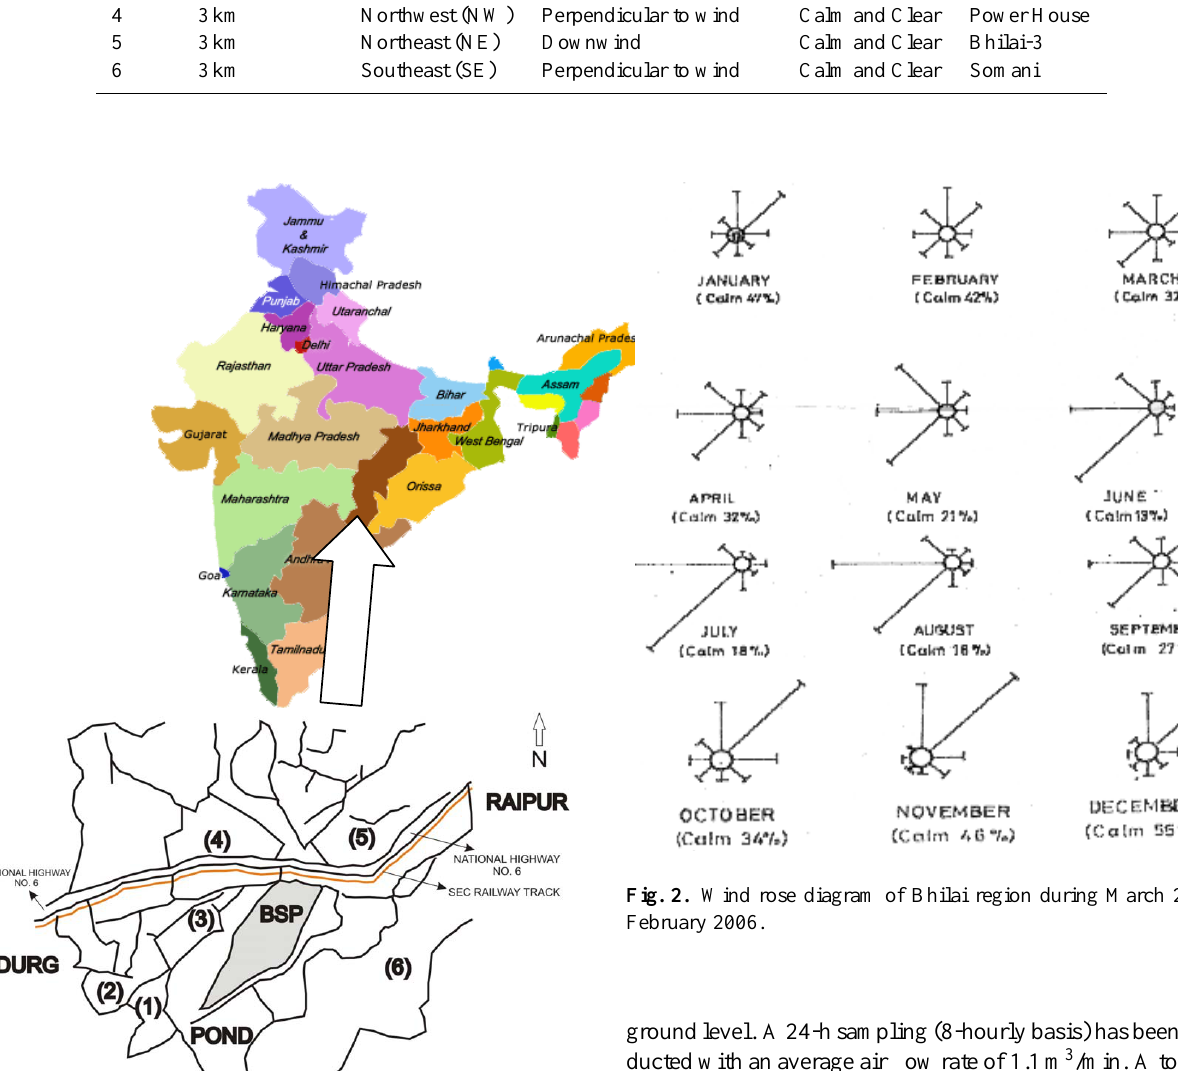
Scale: 1 cm = 3 km Fig. 1. Location map of air sampling sites for monitoring of ambient Fig. 01: Location map of air sampling sites for monitoring of ambient mercury around integrated steel plant, Bhilai, India. mercury around integrated steel plant, Bhilai, India